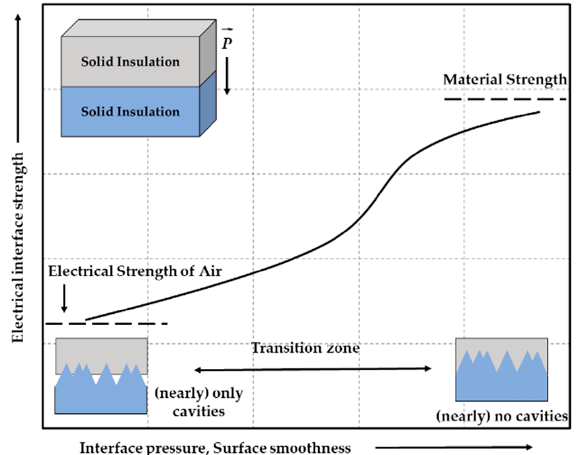
Figure 1. Electrical strength characteristics according to interface pressure [10] .